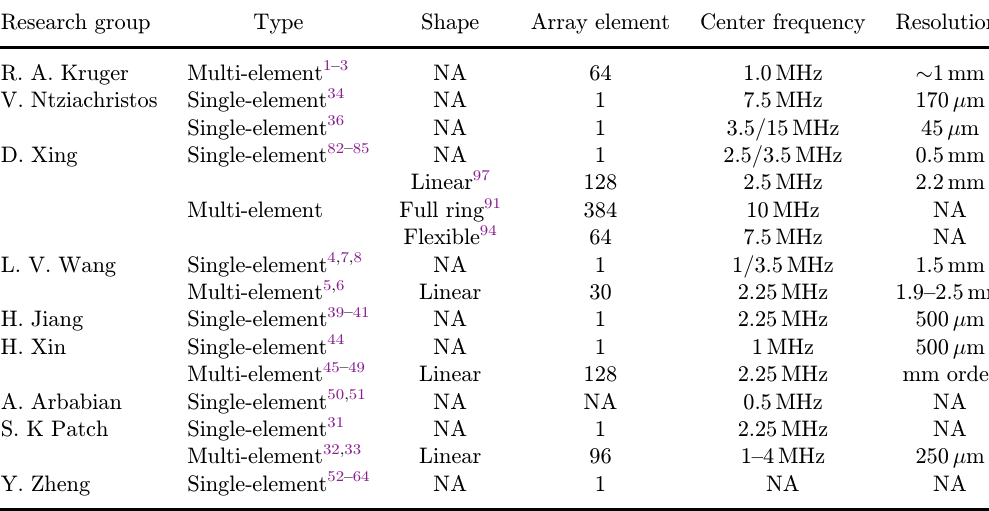
Table 2. Comparison of DAS by research